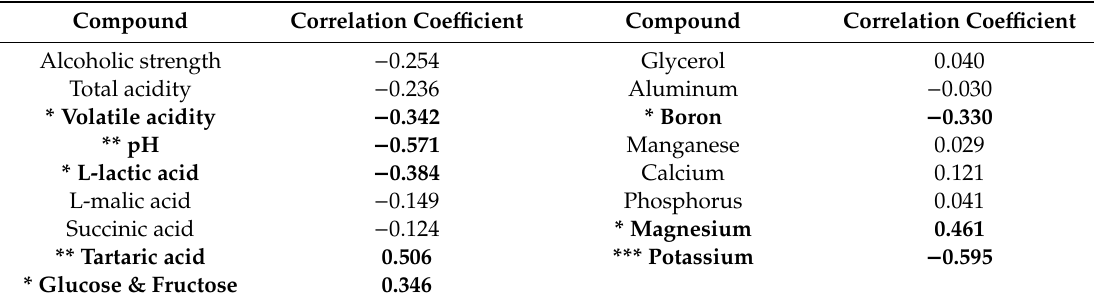
Table 4. Chemical compounds from the eleven white wine samples of the study with correlation at a significant confidence level of 60% with the gustatory “minerality” attribute in white wines (in